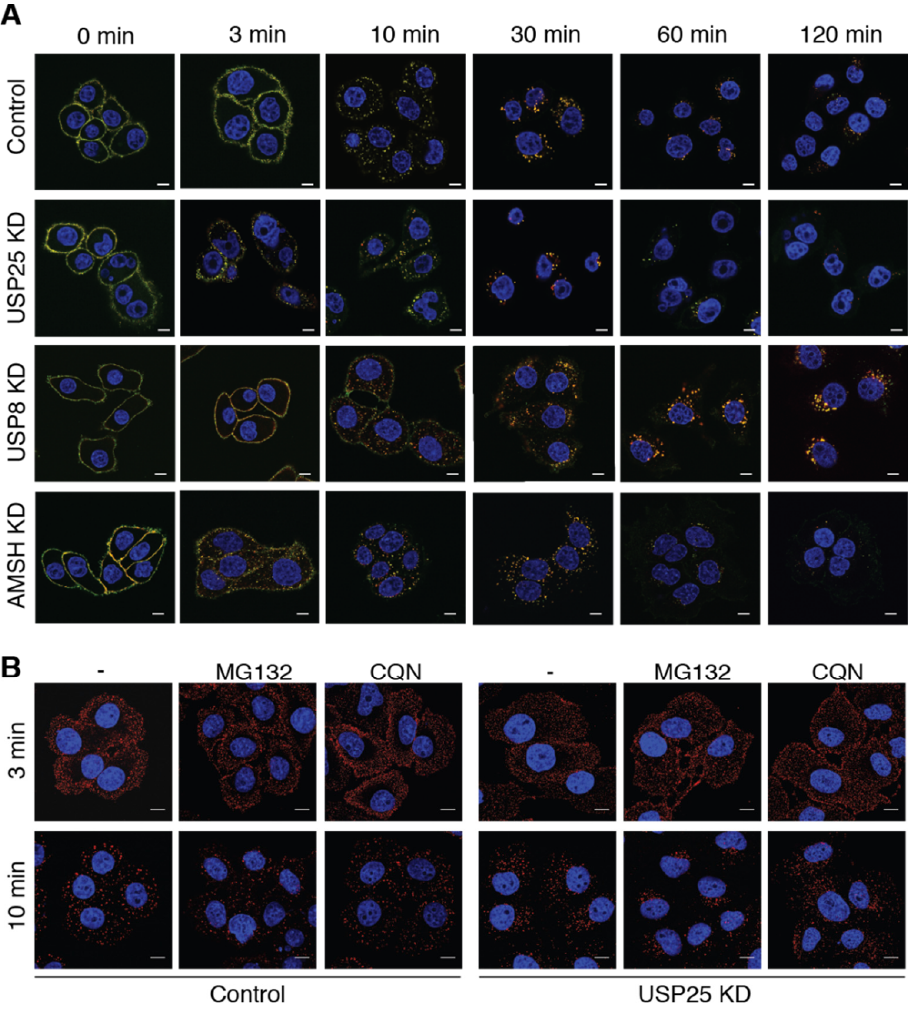
Figure 2. USP25 depletion accelerates EGFR internalization and trafficking. ( A ) IF analysis of HeLa cells transiently transfected with scramble (control), USP25, USP8, or AMSH RNAi oligos. Cells were serum-starved and stimulated with EGF as indicated in Materials and Methods. EGF, red; EGFR, green; DAPI, blue. Scale bar: 10 µ m. EGFR internalization is accelerated in USP25 KD cells (see yellow puncta at the 3 min timepoint). ( B ) Cells treated as in A, were previously incubated with MG132 (20 mM for 1 h) or Chloroquine (CQN 100 mM for 1 h) before stimulation with Alexa555-EGF for the indicated timepoints. EGF, red; DAPI, blue. Scale bar 10 µ m.